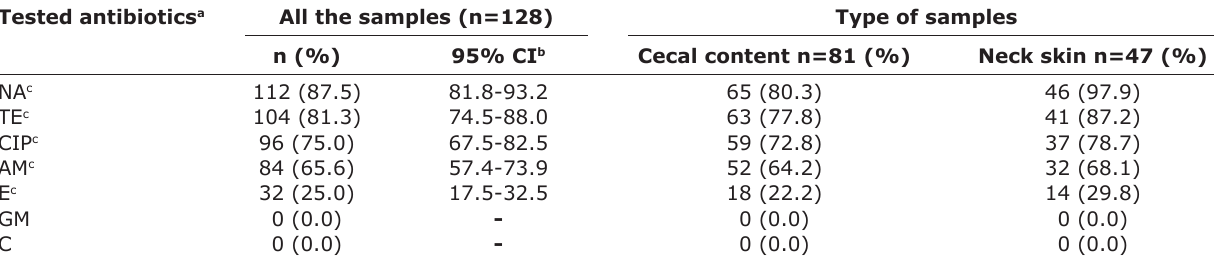
Table-3: Antimicrobial resistance rates of thermophilic Campylobacter strains according to the type of samples. Tested antibiotics a All the samples (n=128)